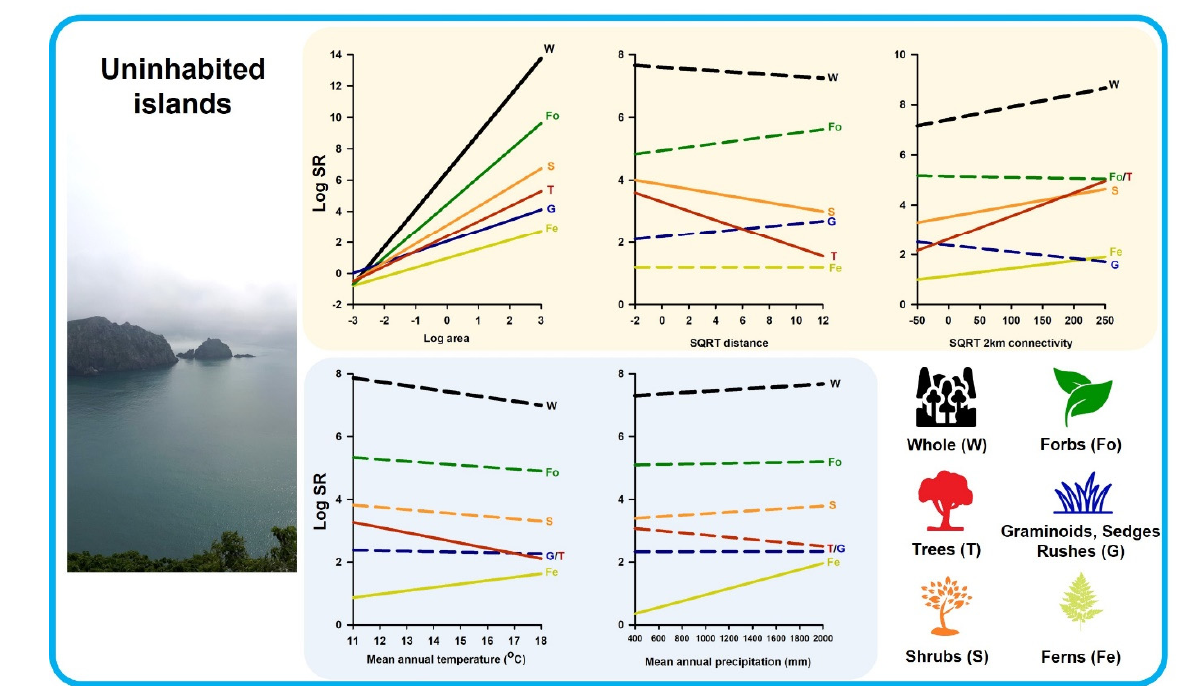
Figure 5. Bivariate relationships between plant growth forms and environmental factors on the inhabited and uninhabited islands, South Korea. Solid and dashed lines represent significant and non-significant effects, respectively. Abbreviations for the factors are shown in Figure 3.